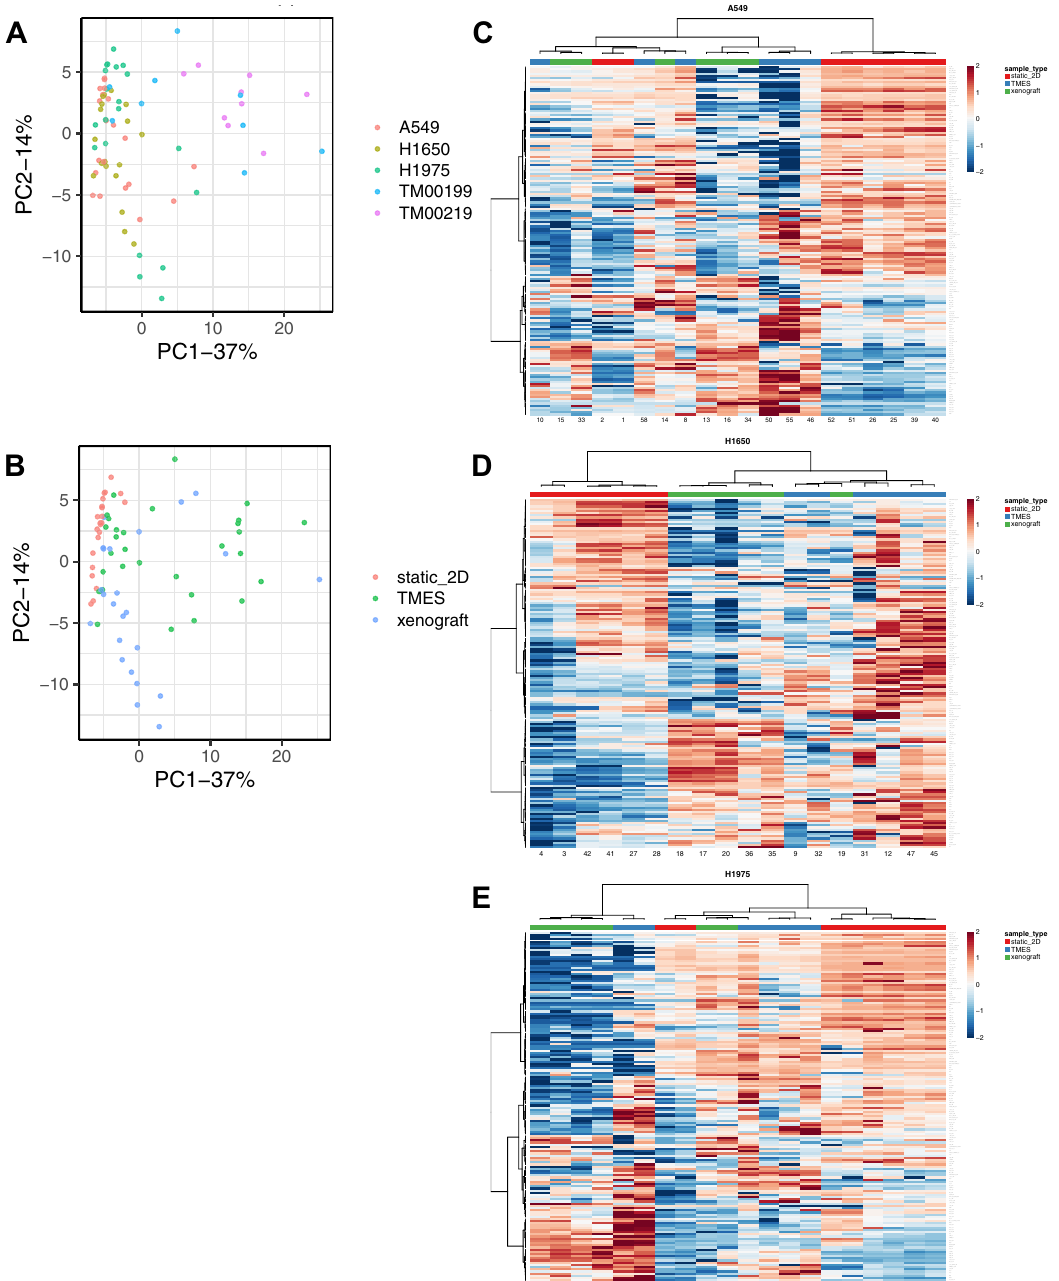
Figure 4. Protein Signal Pathway Analysis of NSCLC in the model systems. Principal Component Analysis of RPPA data from NSCLC tumor cell lines grown in the TMES, xenografts, and static 2D cultures and NSCLC PDX tumor cells grown in the TMES and PDXs. ( A ) PCA color coded by cell, ( B ) PCA color coded by growth condition. Heatmap and cluster analysis of RPPA from ( C ) A549, ( D ) H1650, ( E ) 1975 grown in the TMES, xenografts, and static 2D cultures. The heatmap color scales represents row-wise